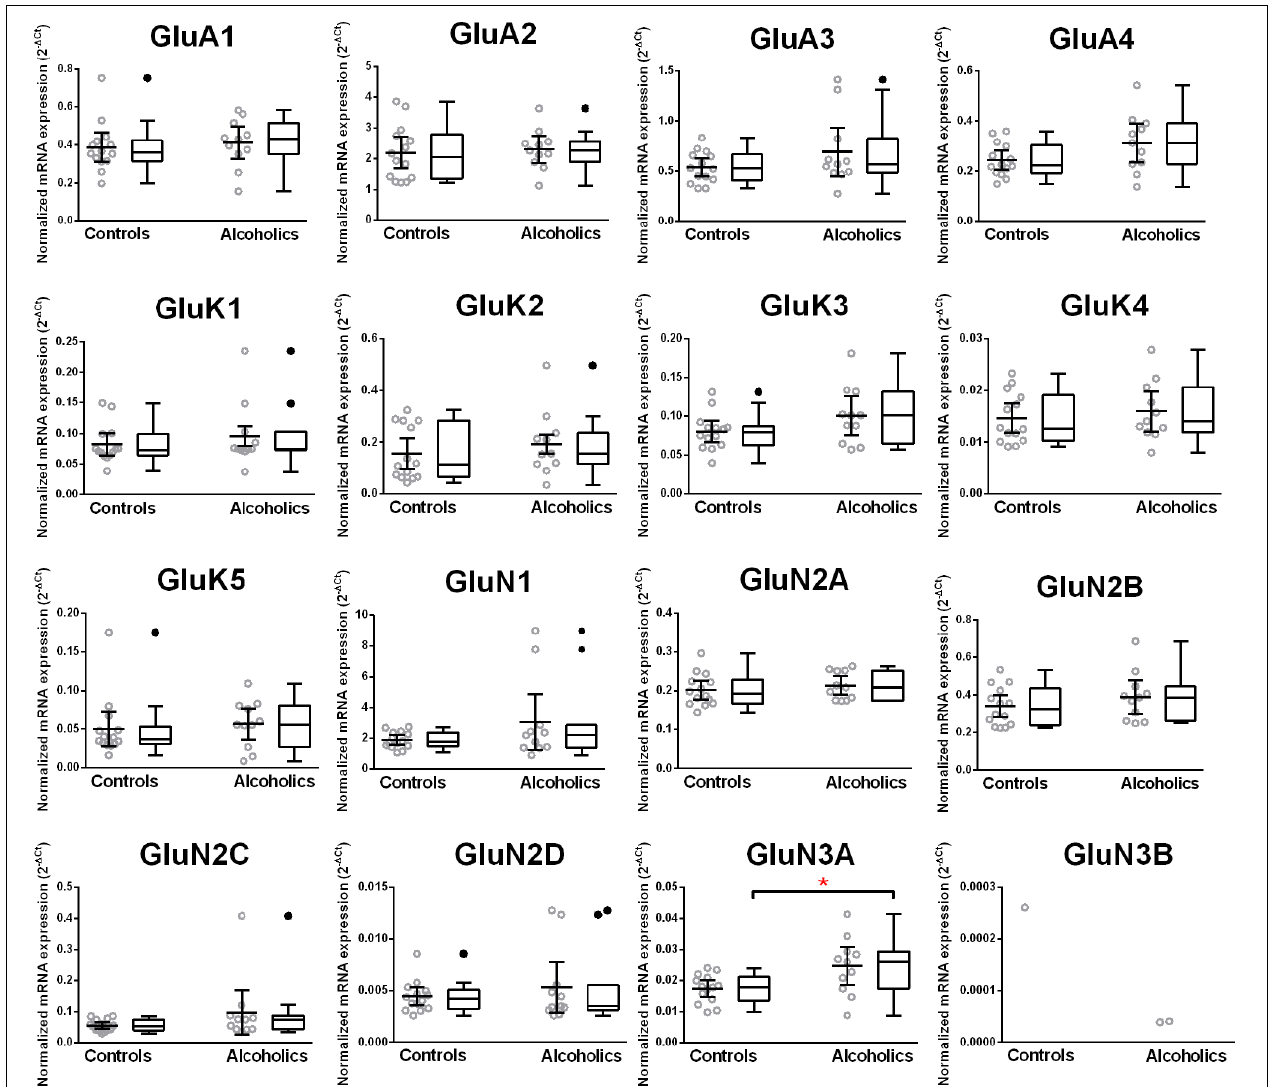
FIGURE 4 | Expression of ionotropic glutamate receptor subunits mRNA in the orbitofrontal cortex of controls ( n = 15) and alcoholics ( n = 14). Data from each group were presented as scatter dot plot ( ◦ ) with mean and 95% confidence interval and box and whiskers plot with median and whiskers plotted by Tukey method to determine outliers ( • -above or below the whiskers). Statistical analysis was performed after excluding outliers. One Way ANOVA with Bonferroni post-hoc test, GluA1, df = 20, p = 0 . 31; GluA2,